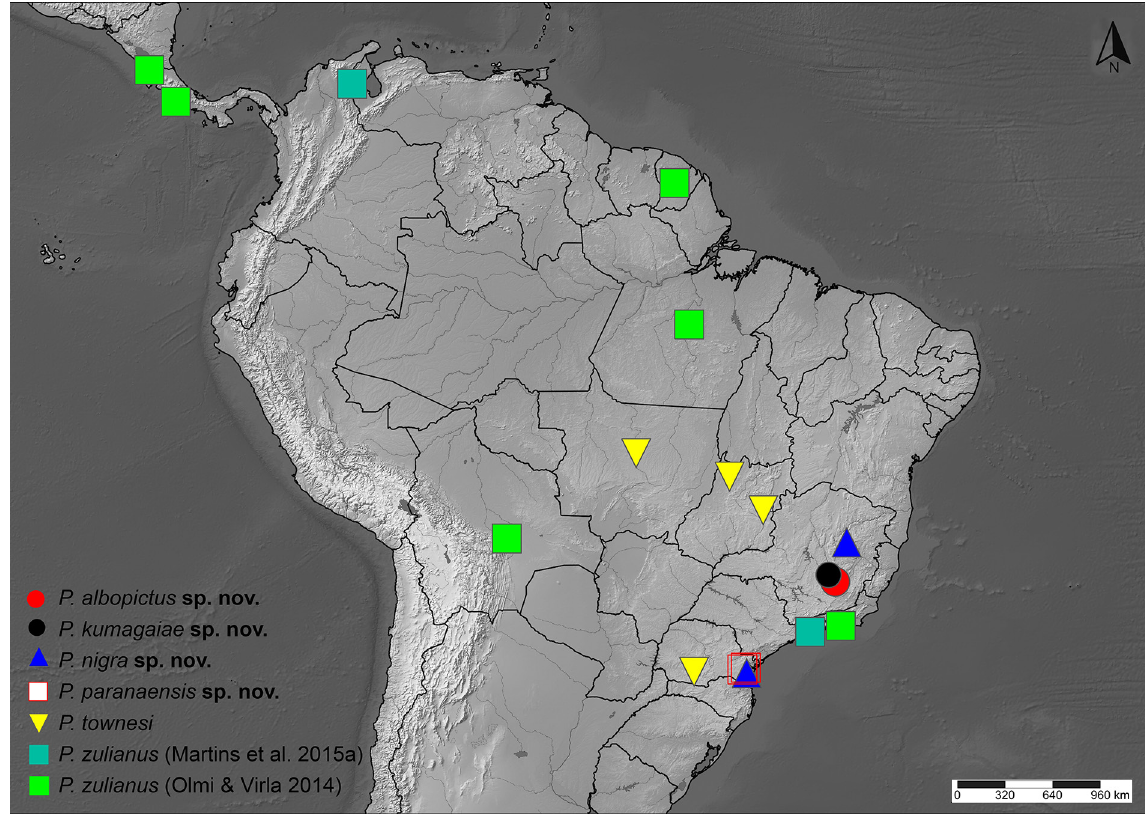
Fig. 11. Geographic distribution of species of Pareucamptonyx Olmi, 1991 from the Neotropical region: P. albopictus Martins sp. nov. (red circle); P. kumagaiae Martins sp. nov. (black circle); P. niger Martins sp. nov. (blue triangle); P. paranaensis Martins sp. nov. (square); P. townesi (Olmi, 1984) (yellow triangle); P. zulianus (Olmi, 1986) (light blue square) (records by Martins et al . 2015a); P. zulianus (light green) (records by Olmi & Virla